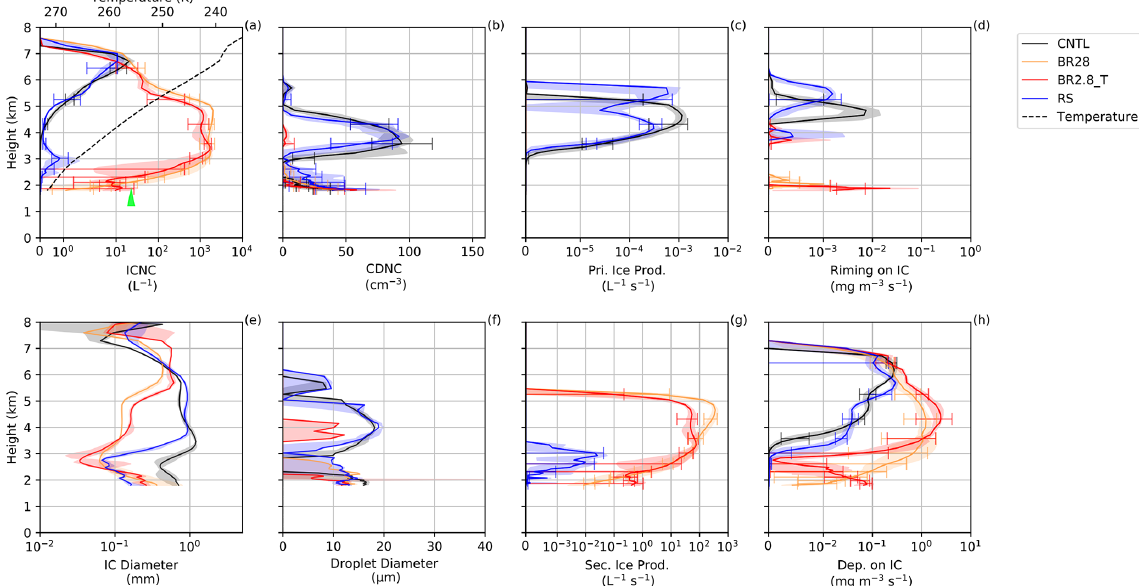
Figure 4. (a, e) Ice crystal number concentration (ICNC) and diameter, (b, f) cloud droplet number concentration (CDNC) and diameter, (c, g) primary and secondary ice production and (d, h) riming and depositional (Dep.) growth of ice at Gotschnagrat at 12:00UTC. The solid lines are the model mean, with error bars showing the model spread for each simulation. The shaded regions are the minimum and maximum values for the four closest model points. The mean ice diameter is denoted by IC. The green arrow is the average ICNCs from the HoloGondel measurements (Fig. 3a).